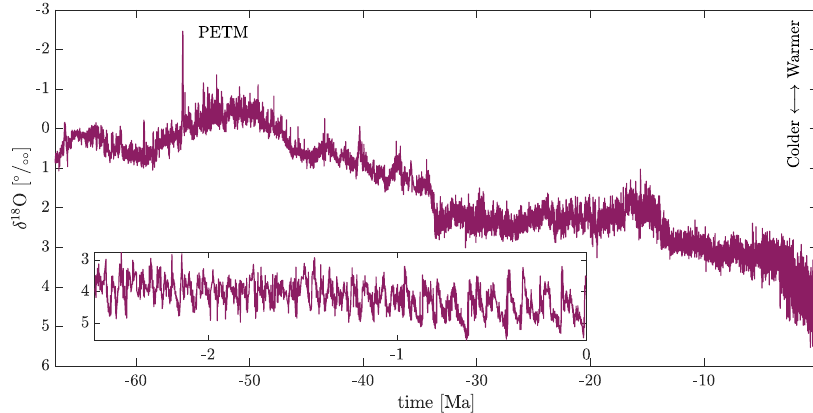
Fig. 1 δ 18 O over the Cenozoic (66Ma-present), from 8 . Inset is the same for the most recent 2.6